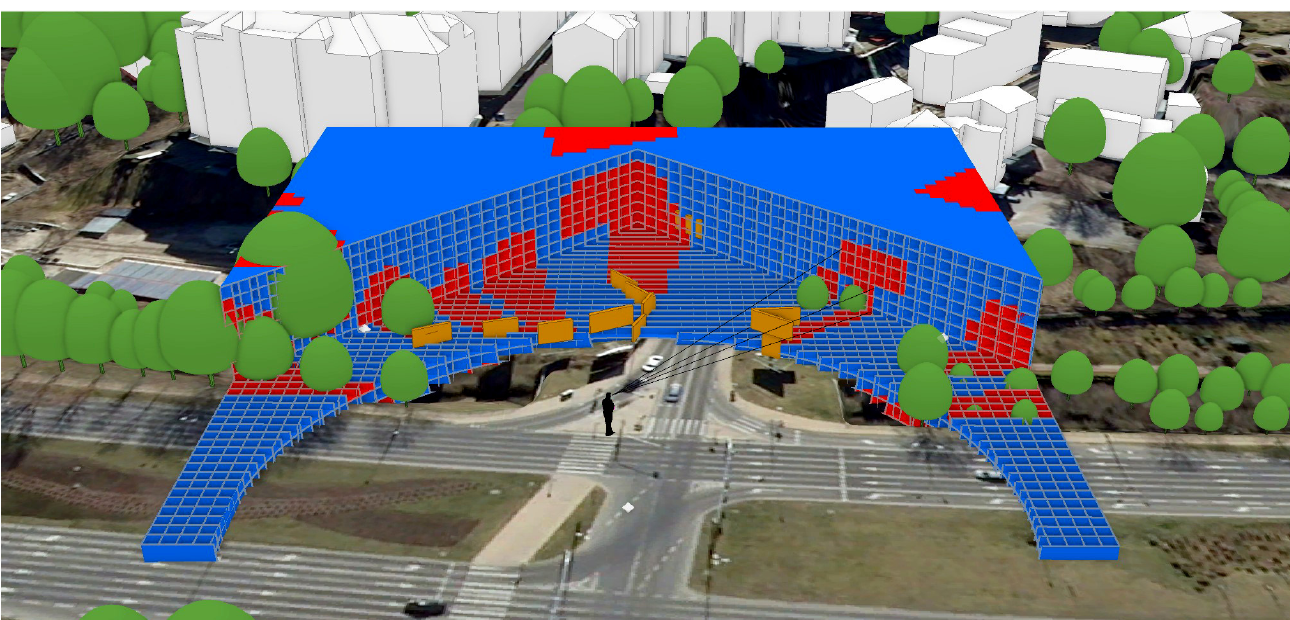
Figure 1. Two subsets of observer’s view volume: the visible view volume (VVV) referred to landscape openness (blue) and occluded view volume (OVV, red color). The subsets are represented using voxels, the voxels visibility status is determined by 3D ISOVIST analysis. The OOHb infrastructure is orange. The subsets balance is analyzed within the voxels bounding box, centered to the observer’s position (the cross-section view).